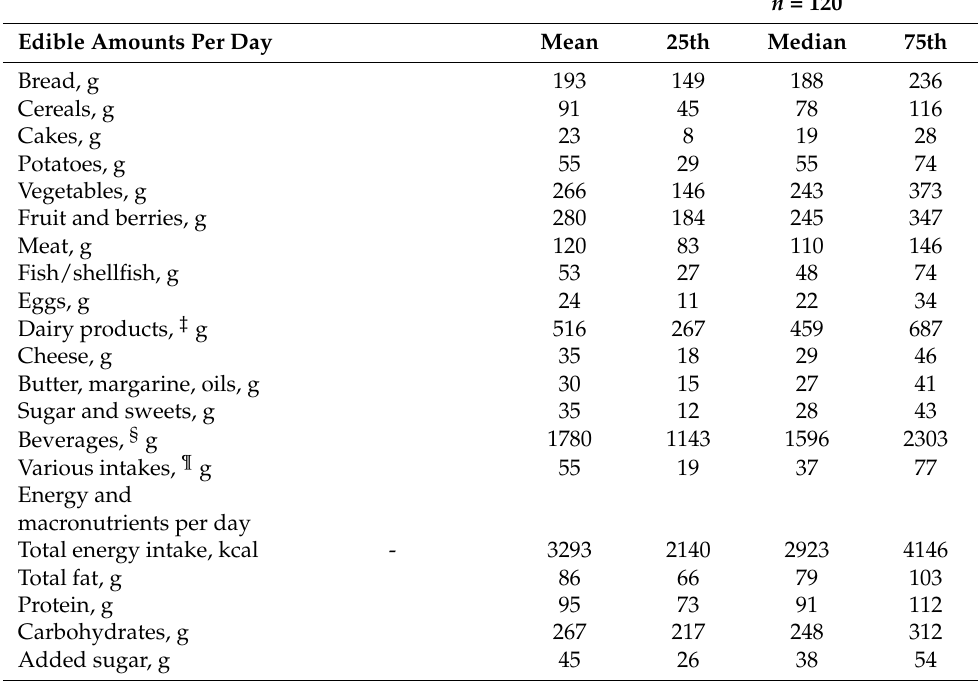
Table 3. Daily intakes of main groups of foods, beverages, and nutrients, including supplements, in early pregnancy among women with pre-pregnancy obesity. Observed data presented as mean and median with 25th and 75th